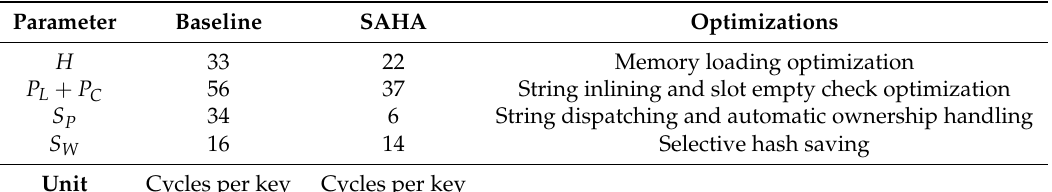
Table 2. Comparison of the complexities of cost model parameters with and without